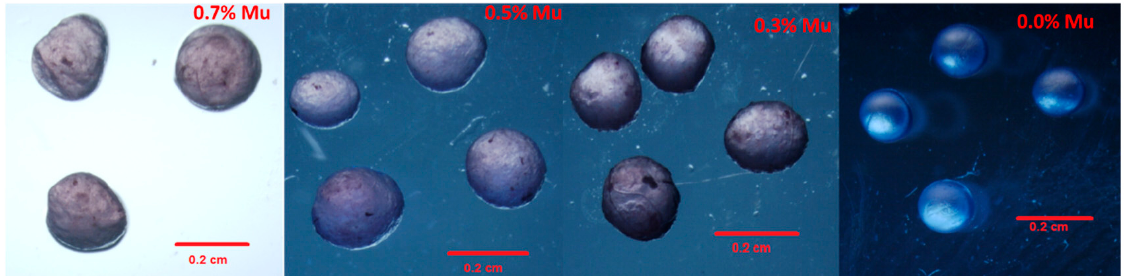
Figure 2. Shapes of the capsules obtained for the solutions at different mucilage and alginate concentrations.